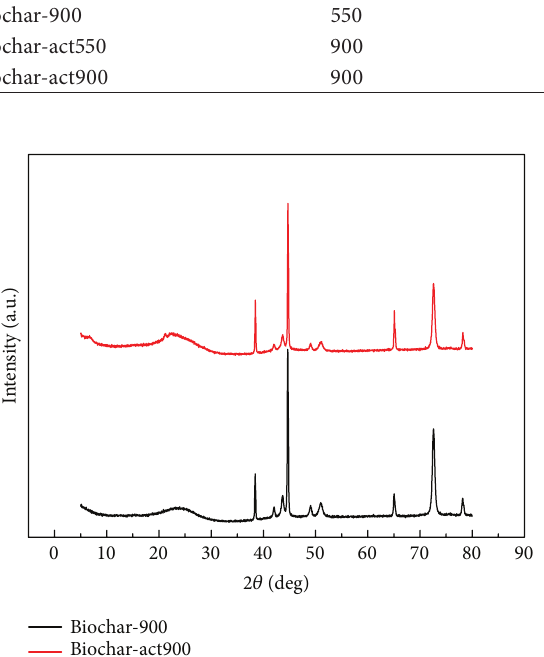
Figure 5: XRD patterns of Biochar-900 and Biochar-act900.